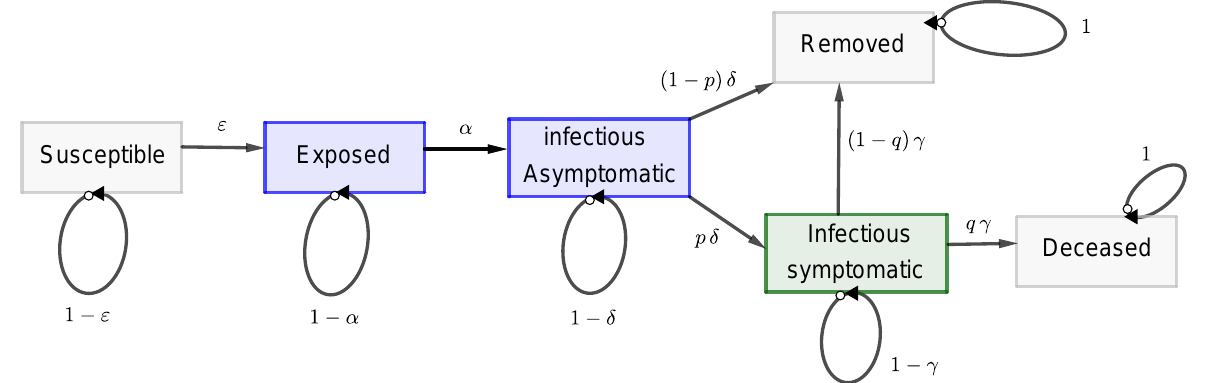
Figure 1. Flow diagram of the SEA-RID non-linear Markov chain in discrete time. Infection process with probability ε = 1 − e − ( β 1 A + β 2 I ) / ( 1 − D ) depending on the # of infectious hosts, either asymp- tomatic or symptomatic, over alive population. No demographic turnover. Complete immunity along each epidemic outbreak. 0 < α , δ , γ , p , q < 1 are the probabilities of the model and β 1 , β 2 > 0 are rates of the infection transmission. Virulence is measured as disease-induced mortality q γ